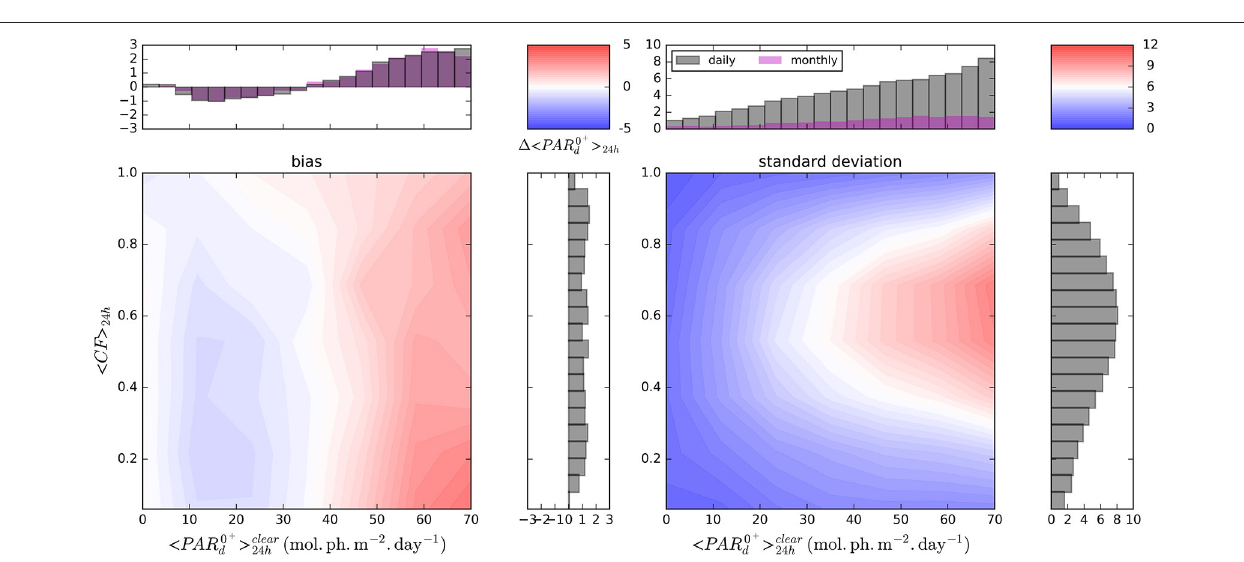
FIGURE 18 | Error budget of the daily “MERIS” PAR product above the surface (estimated PAR–actual PAR) from simulations for the period 2003–2012 using 1-hourly resolved MERRA-2 input data. For each day, a set of MERIS spectral reflectance data is simulated for a typical observation at 10:30 UT local time and several viewing geometries (nadir and 20 ◦ view zenith angle (VZA) with relative azimuth of 0, 90, and 180 ◦ , with sun glint avoidance). (Left) 2D plot of the error bias as a function of the clear sky daily PAR above surface (x axis) and cloud factor (y axis), along with 1D (marginal) distribution. (Right) Same as left but for the error standard deviation. For the 1D marginal distribution as a function of the clear-sky PAR is also reported the monthly PAR error bias and standard deviation in